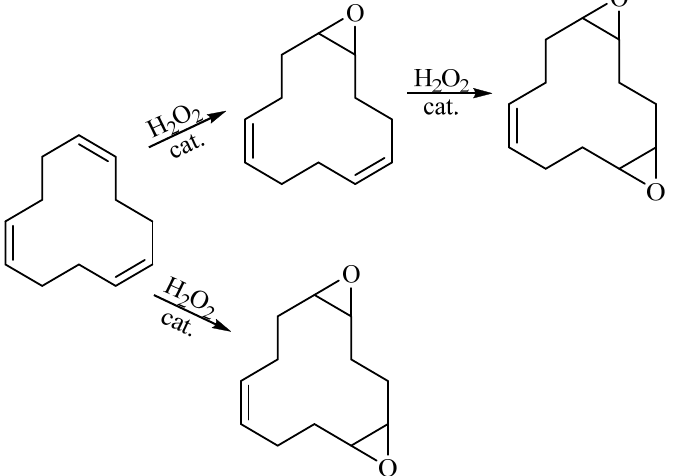
Figure 3. Schematic diagram of the 1,5,9-cyclododecatriene (CDT) epoxidation process.